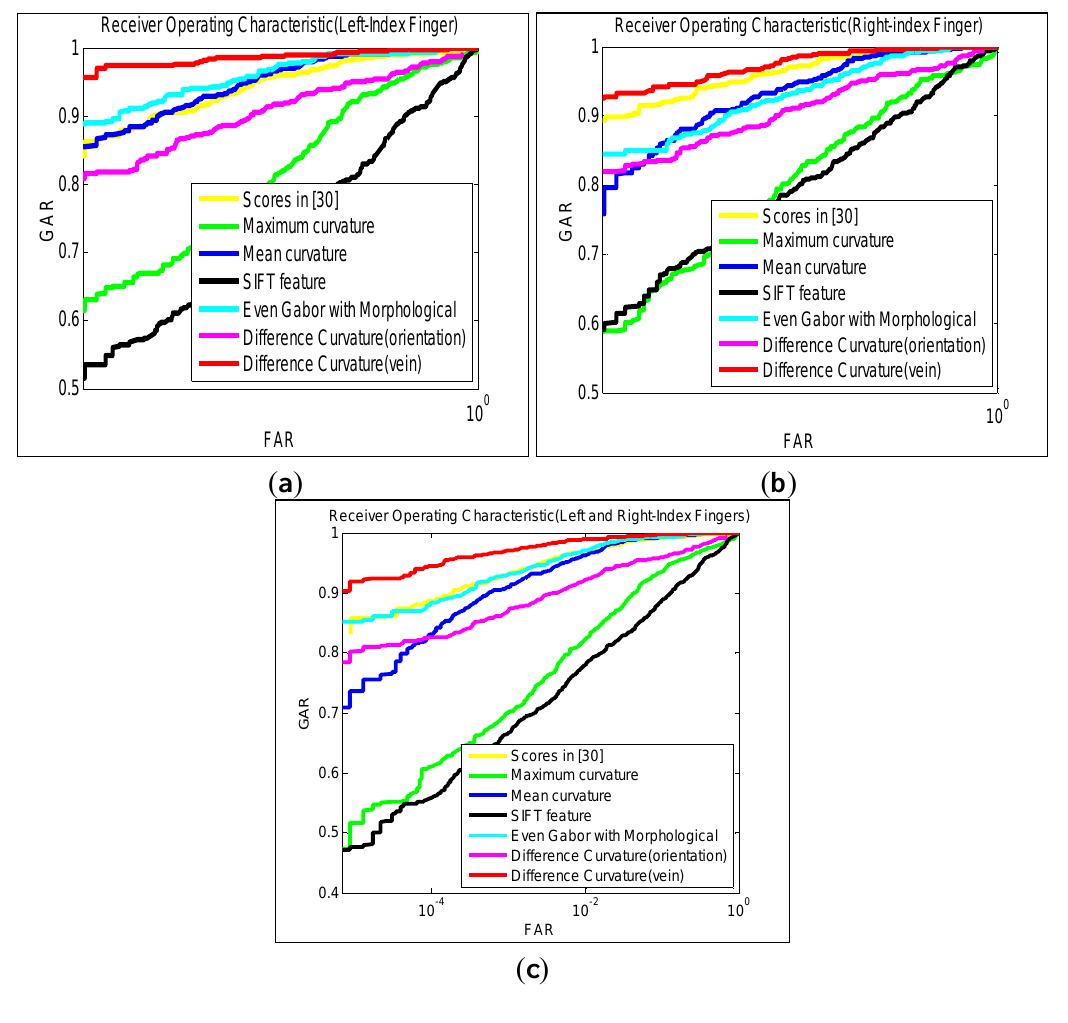
Figure 6. Receiver operating characteristics from finger-vein images (Database B). ( a ) Left index-finger ( b ) Right index-fingers ( c ) Left and right